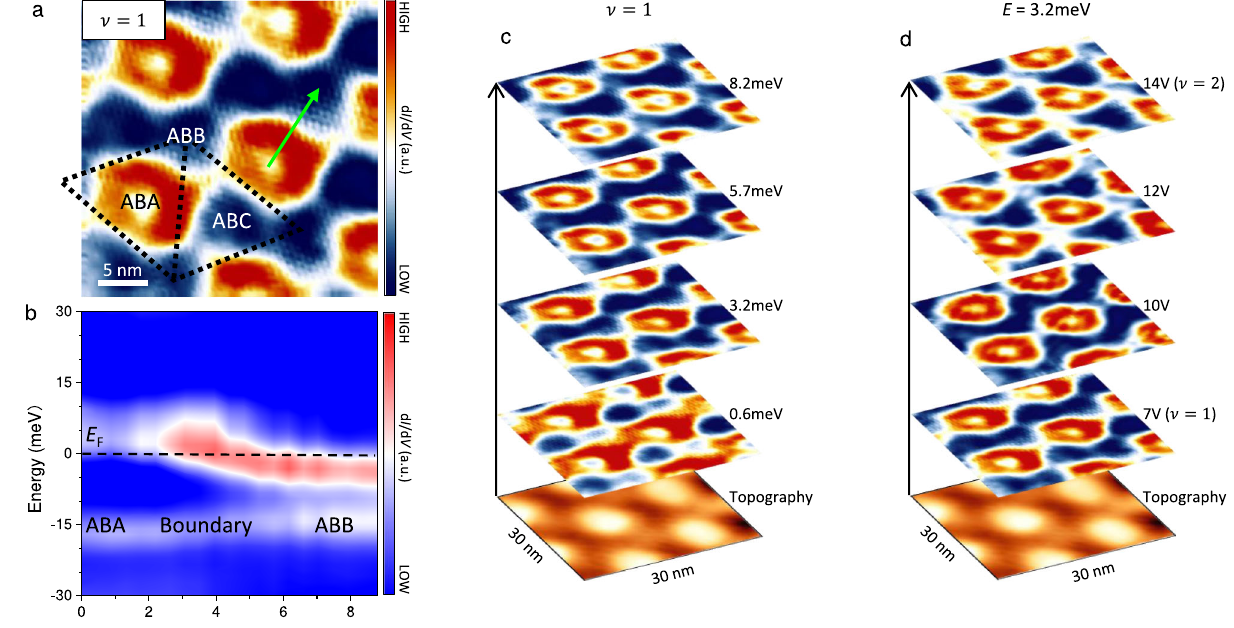
Fig. 4 Topological torus lattice. a A typical d I /d V map at ν ¼ 1 near E F . The torus-shaped structure shows up with bright red color ( V b = − 50 mV, I = 200 pA). The dotted rhombus labels the moiré superlattice. b Evolution of the d I /d V intensity from the ABA to ABB region along the arrow in ( a ). The dashed line indicates E F . The red color near E F indicates the enhancement of LDOS at the torus-shaped structure. c Stacking of d I /d V maps at ν ¼ 1 as a function of energy which are labeled nearby ( V b = − 50 mV, I = 200 pA). The bottom image shows the STM topography simultaneously obtained during these maps. d Stacking of d I /d V maps as a function of doping level which are labeled nearby ( V b = − 50 mV, I = 200 pA). The bottom image shows the STM topography simultaneously obtained during these